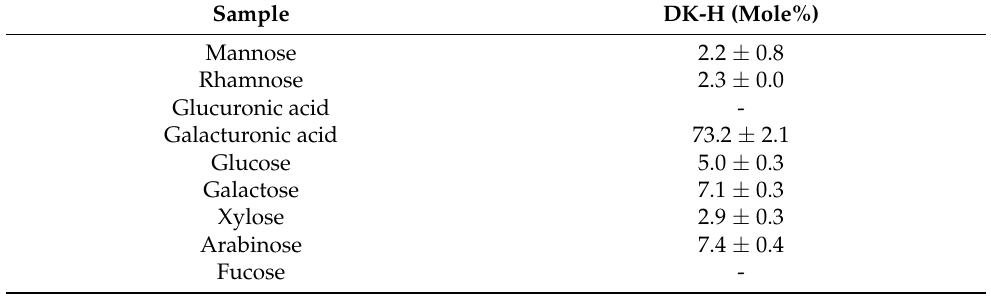
Table 2. Sugar composition analysis of high-molecular-weight fraction (DK-H) isolated from D. kaki extract using high-performance gel filtration chromatography.